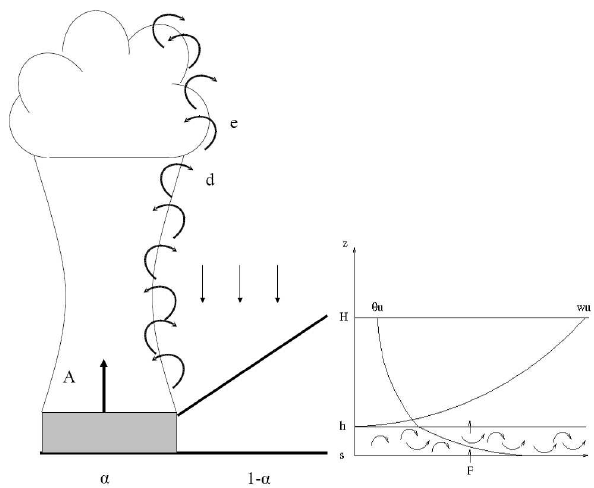
Fig. 2. Schematic view of the pyro-thermal generated by a fire (left) and zoom on the feed layer (right): diffusion is dominant in a layer of depth h near surface while transport by thermals is dominant above. The plume covers a fraction α of the grid cell and is gen- erated by the excess of temperature induced by fires leading to a vertical velocity w u , a potential temperature θ u and a mass-flux A at the top of the feed layer of height H . The plume mixes with environmental air at each level at rates e and d Table 1. Comparison of plume characteristics (injection height, virtual potential temmperature excess, maximum vertical velocity and cloud base) as obtained with the ATHAM high resolution model in Trent- mann et al. (2006) and with the pyro-thermal plume model.